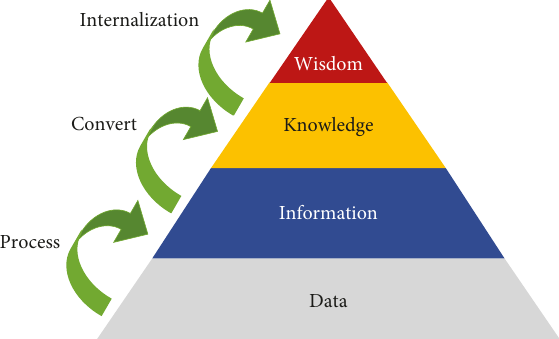
Figure 1: Schematic diagram of DIKW system.